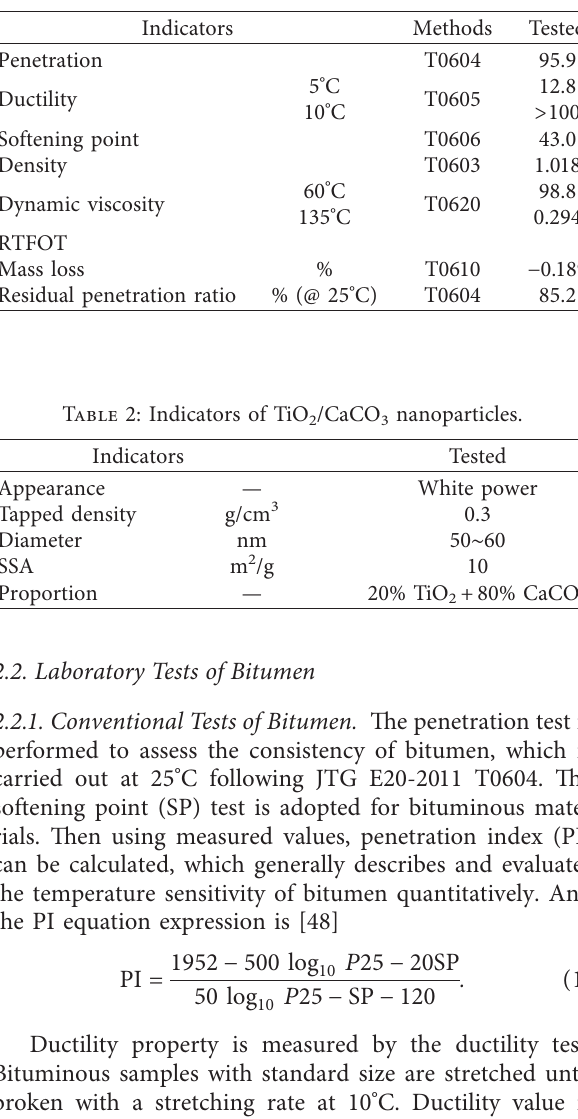
Table 1: Indicators of AH-90. Indicators